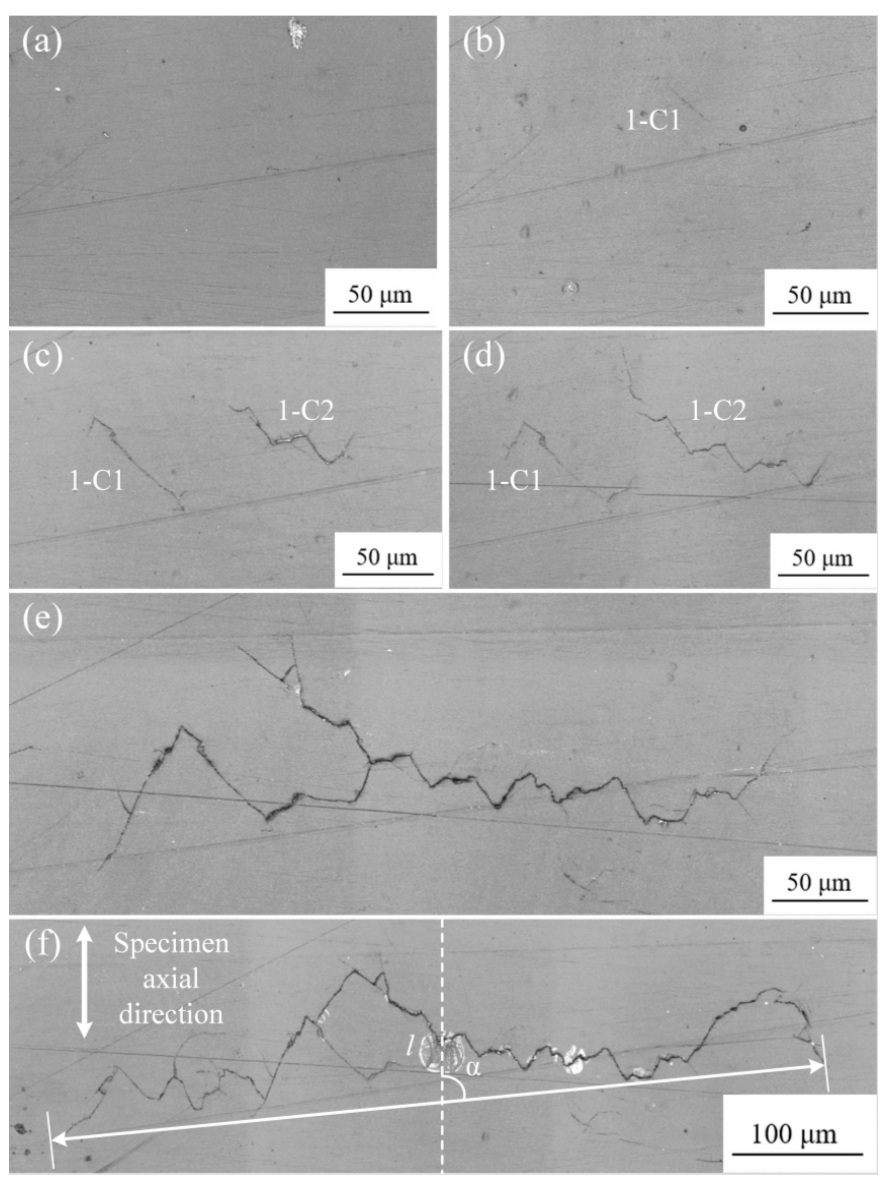
Figure 6. Replica photos of the typical stages for specimen ORB2-Crack #1: ( a ) N = 0; ( b ) N = 1000; ( c ) N = 10,000; ( d ) N = 20,000; ( e ) N = 50,000; ( f ) N = 80,000.